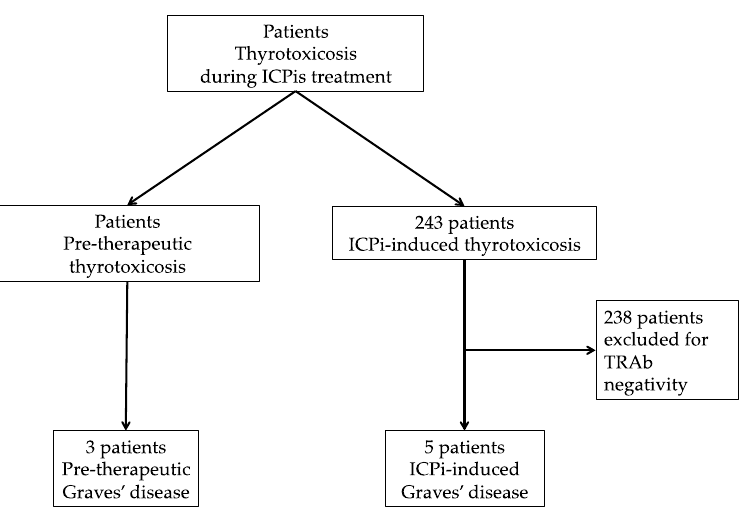
Figure 1. Flow chart. ICPis: immune checkpoint inhibitors; TRAb: TSH-receptor autoantibodies. For patients 1 and 2, the course of the thyrotoxicosis was typical of a Graves’ hy- perthyroidism (Figure 2A.): both were treated with an antithyroid drug (ATD) and TSH normalized quickly; TRAb normalization occurred after more than 6 months. Total du- ration of ATD treatment was about one year for patient 1, with a slow decrease in ATD treatment until spontaneous euthyroidism; patient 2 was still undergoing treatment with ATD after 6 months because early tapering of treatment resulted in early recurrence of hyperthyroidism. Both patients were treated with corticotherapy for an additional grade 3 irAE (for patient 1, subsequent autoimmune hepatitis, and for patient 2, consecutive autoimmune pneumopathy); these irAEs resulted in the withdrawal of ICPis.